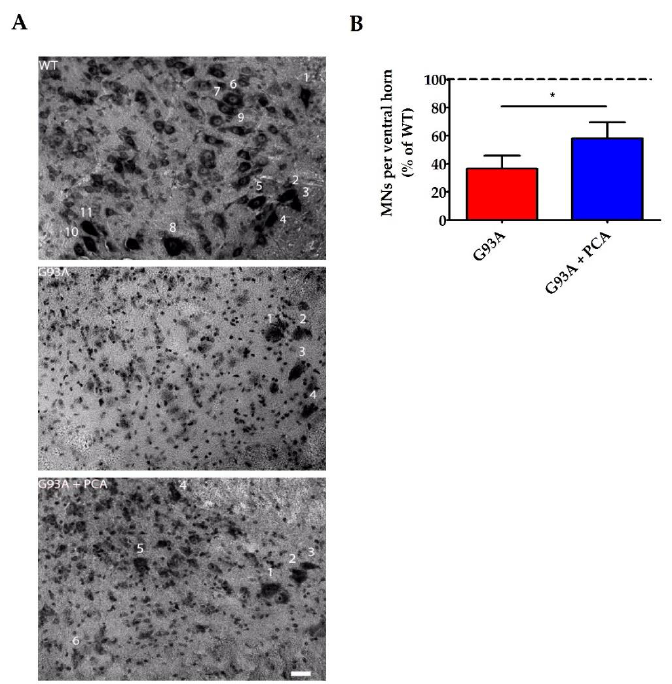
Figure 5. PCA treatment significantly preserves motor neurons in the ventral horn of the spinal cord in the hSOD1 G93A mouse model of ALS. ( A ) Representative images of lumbar spinal cord ventral horns from wildtype control mice (WT), untreated hSOD1 G93A control mice (G93A) and hSOD1 G93A mice treated orally with 100 mg/kg PCA beginning at disease onset (G93A+PCA). Mice were euthanized at end stage of the untreated hSOD1 G93A littermate control mouse and ventral horns were Nissl stained to label neuronal cell bodies. Stained soma were measured along the longest axis and cells were considered alpha motor neurons if the length was greater than 20 μm. Scale bar = 20 μm. ( B ) Quantification of Nissl-stained alpha motor neurons as described in A. The number of alpha motor neurons in the ventral horns of lumbar spinal cord of untreated and PCA-treated hSOD1 G93A littermate mice were normalized and expressed as a percentage of the number of alpha motor neurons measured in the WT littermate control mouse. Data are expressed as the mean ± SEM; n = 7 mice per group; 4 – 6 ventral horns were imaged per mouse. * indicates p < 0.05 compared to untreated hSOD1 G93A littermate controls (paired t -test). Mean number of alpha motor neurons present in the ventral horn lumbar spinal cord for the untreated hSOD1 G93A littermate mouse (1.92 ± 0.47) is significantly less than that of the WT (5.55 ± 0.57) ( p = 0.004; n = 7 mice per group). Abbreviations used: MNs = motor neurons.